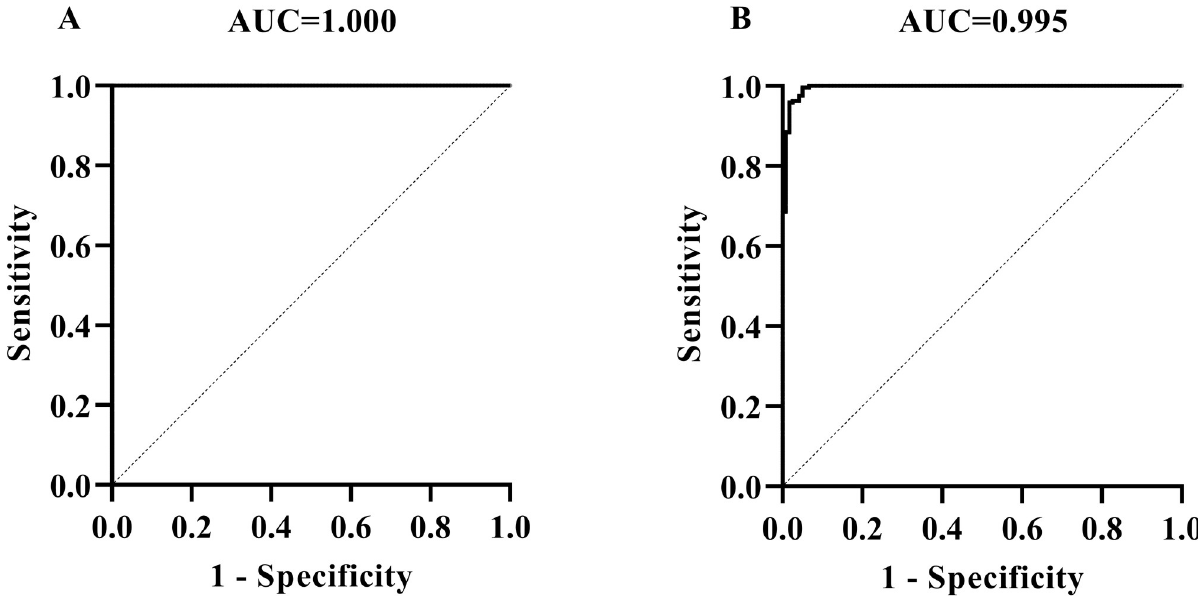
Fig 2. Determination of cut-off values, diagnostic sensitivities, and specificities of MMEC/AG-iELISA for M . bovis caused bTB by using the maximum AUC. The ROC curves of MMEC/AG-iELISA for detecting antibodies in serum samples at dilutions of 1:50 (A) and 1:100 (B).